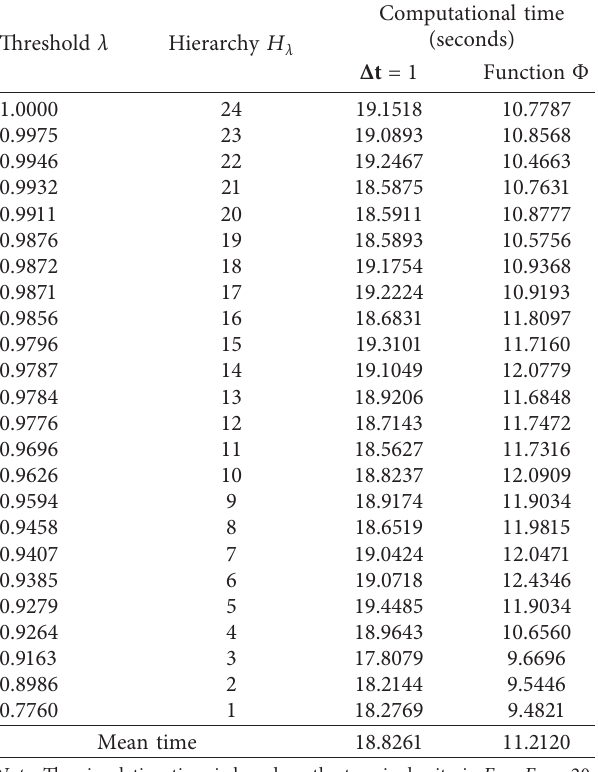
Table 7: Simulation time of DEDS with different discrete time Δt under each train hierarchy.